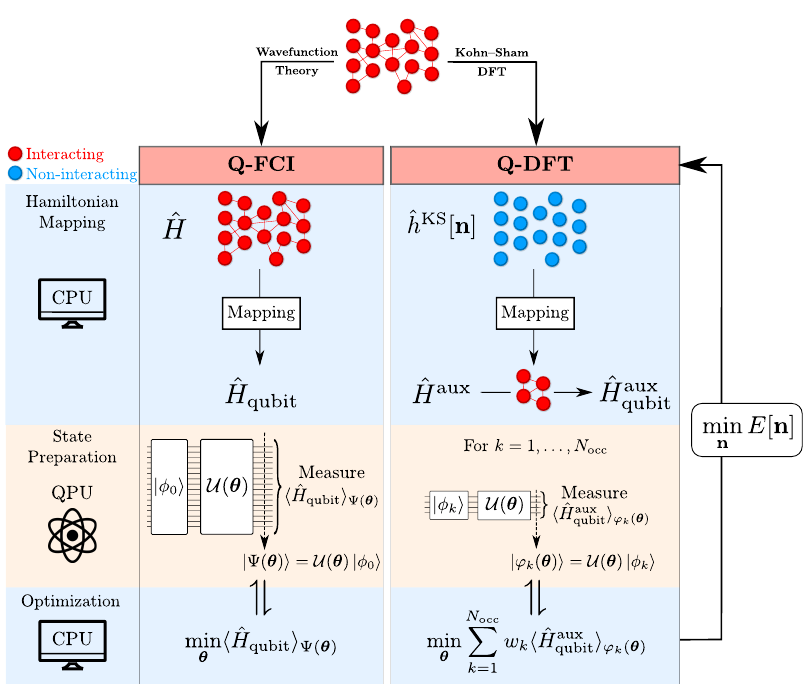
Figure 2: Flowchart of the quantum algorithm analog of FCI (Q-FCI) and DFT (Q- DFT) for N = 16 spin-orbitals, using variational quantum algorithms as solvers. The ground-state VQE and ensemble-VQE are used in Q-FCI and Q-DFT,